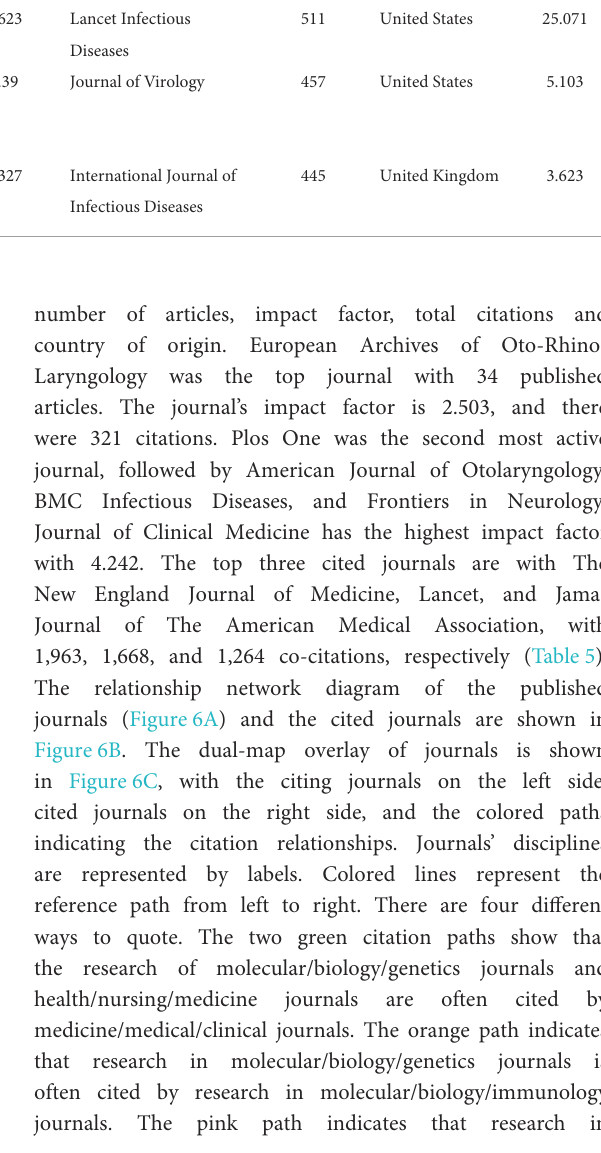
Figure 6B. The dual-map overlay of journals is shown in Figure 6C, with the citing journals on the left side, cited journals on the right side, and the colored paths indicating the citation relationships. Journals’ disciplines are represented by labels. Colored lines represent the reference path from left to right. There are four different ways to quote. The two green citation paths show that the research of molecular/biology/genetics journals and